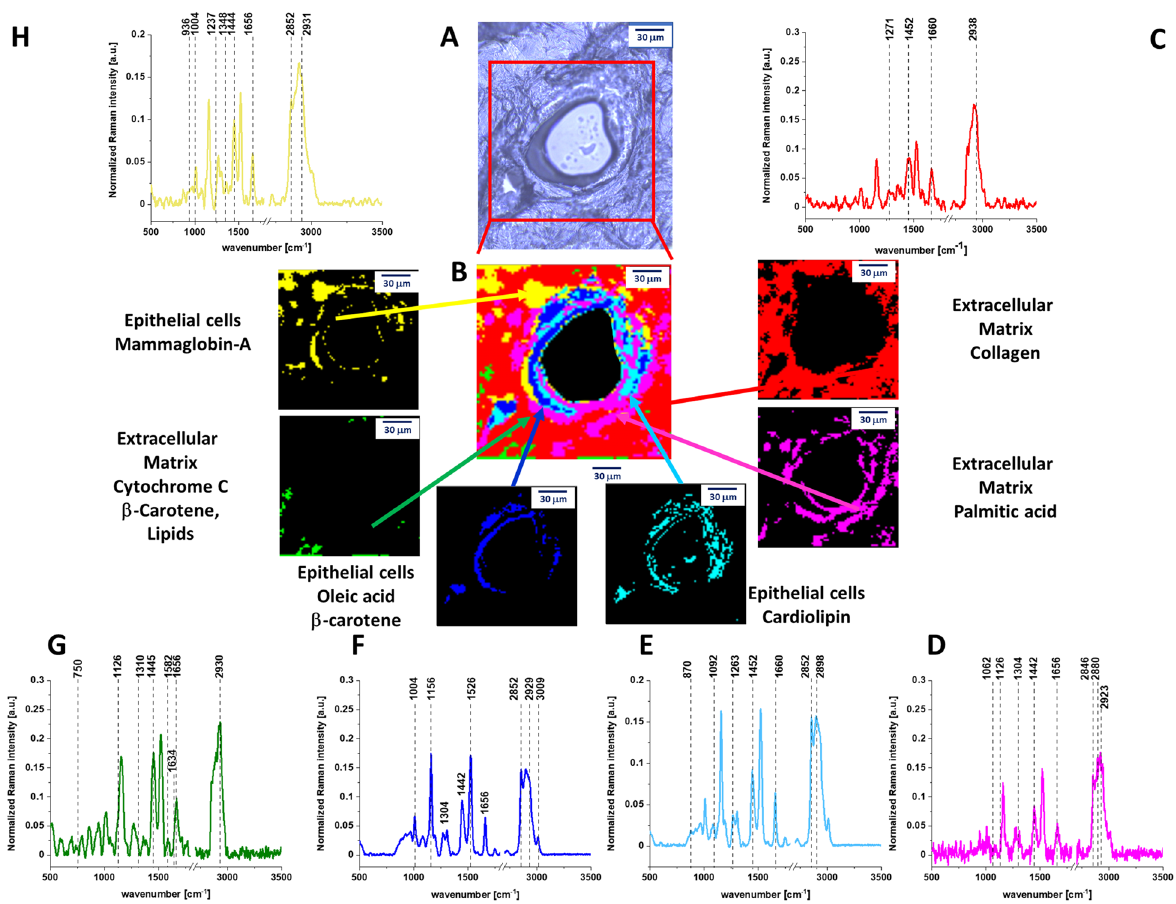
Figure 1. ( A ) Microscopy image of human normal duct, ( B ) Raman imaging of human normal duct obtained by using Cluster Analysis and Raman images and average Raman spectra (normalized by norm) of all clusters identified by Cluster Analysis: ( C ) collagen (red), ( D ) palmitic acid (pink), ( E ) cardiolipin (turquoise), ( F ) oleic acid, ( G ) (blue), cytochrome c (green), ( H ) mammaglobin-A (yellow).